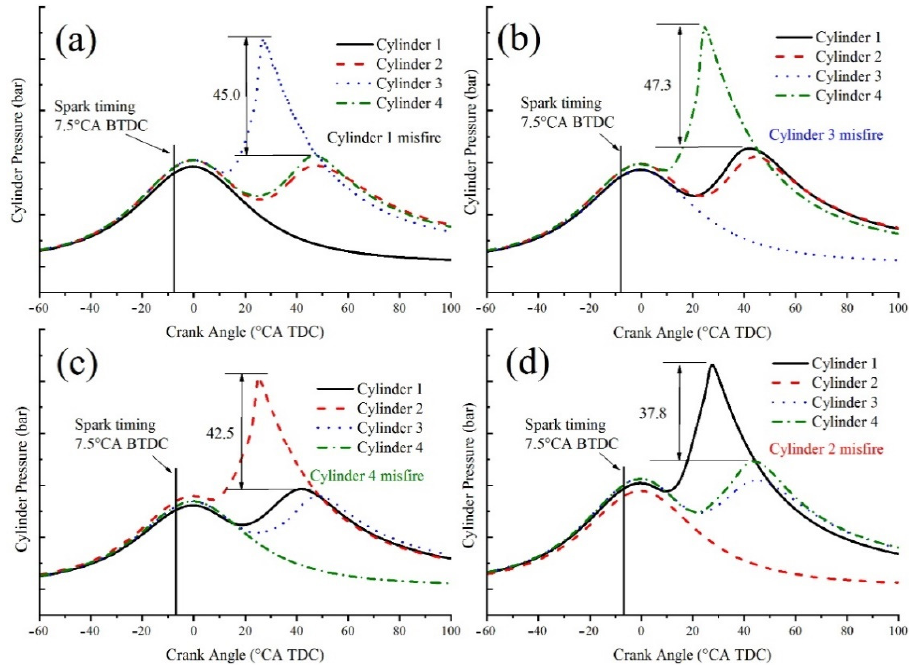
Figure 6. Abnormal combustion in the next ignition cylinder corresponding to the misfired cylinder: ( a ) misfired in cylinder 1; ( b ) misfired in cylinder 3; ( c ) misfired in cylinder 4; ( d ) misfired in cylinder 2.